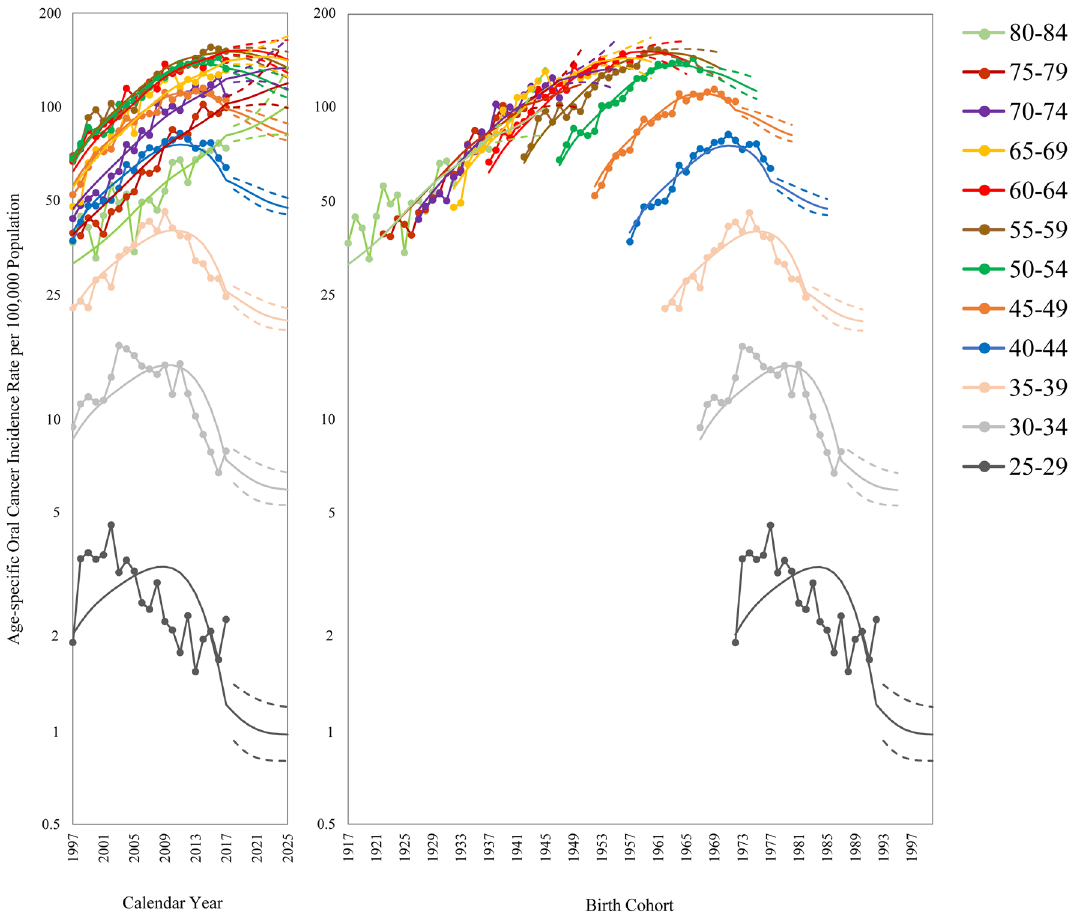
Figure 2. Age-specific oral cancer incidence rates among men in Taiwan by calendar year and birth cohort (age range: 25–84